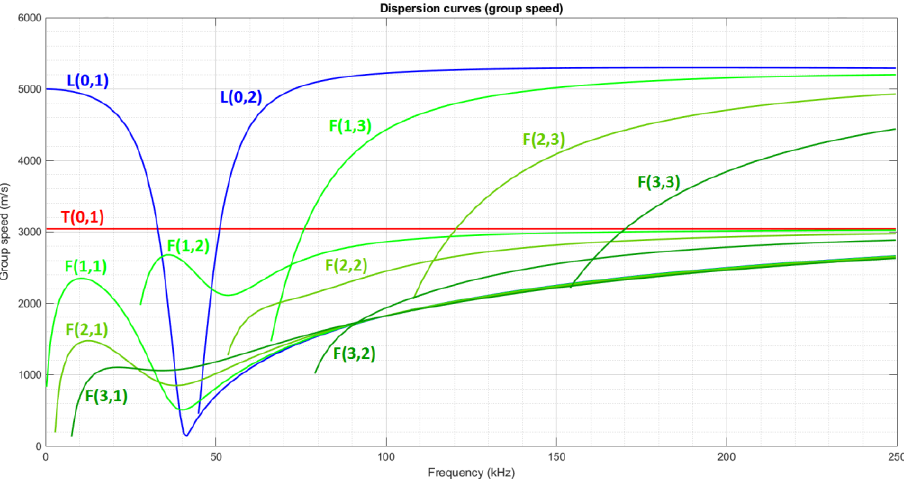
Figure 4. Group speed for the main wave modes in an aluminium pipe of Ø 40 mm and 1.5 mm